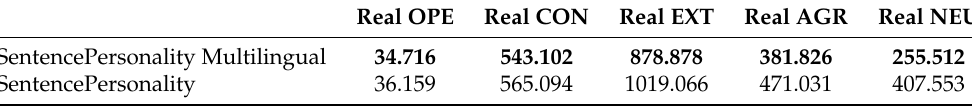
Figure 15. Neuroticism: Histograms representing data distribution of gold standard on the left, our English model result in the middle, and our multilingual model result on the right. Table 9. Kullback–Leibler divergence comparing English and multilingual